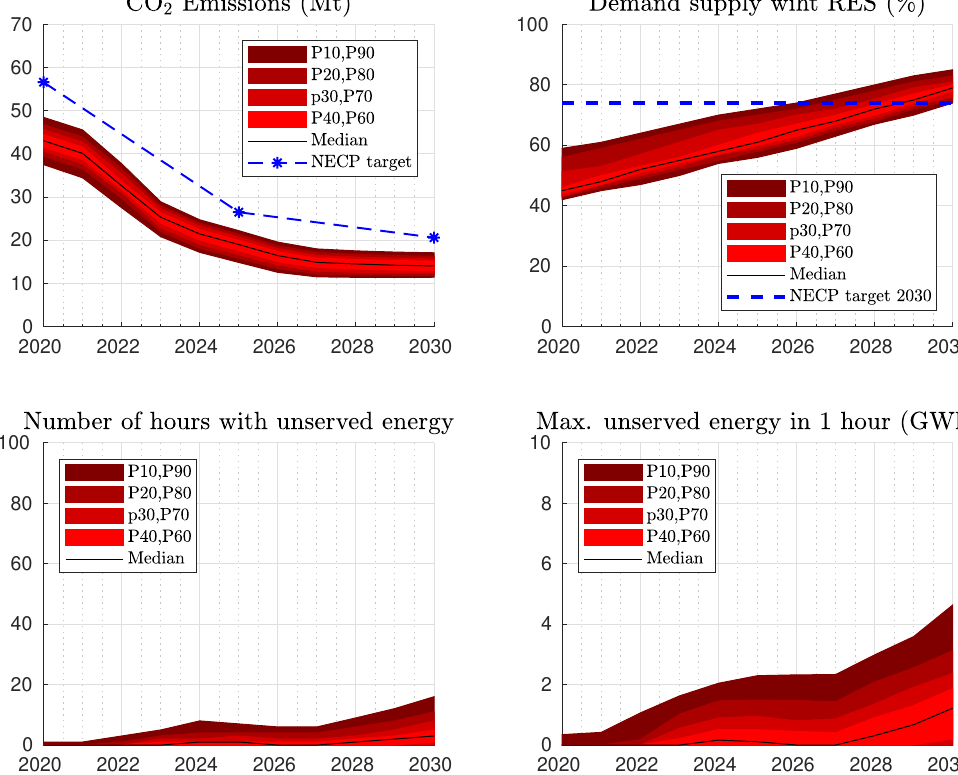
Figure 10. Performance indicators for transition path NECP-no coal